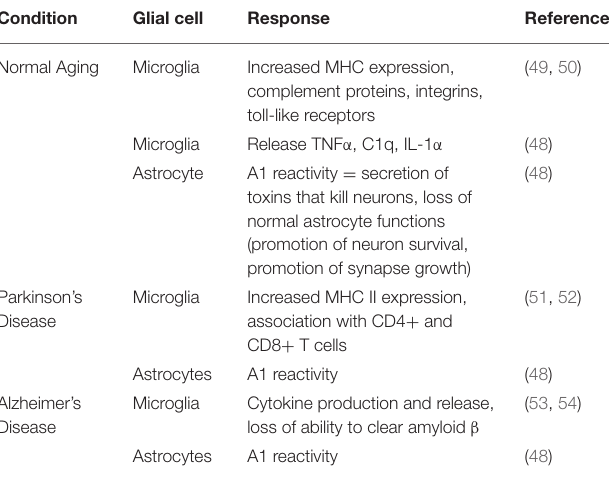
TABLE 2 | Glial cell responses to inflammation in normal aging and neurodegenerative disorders.